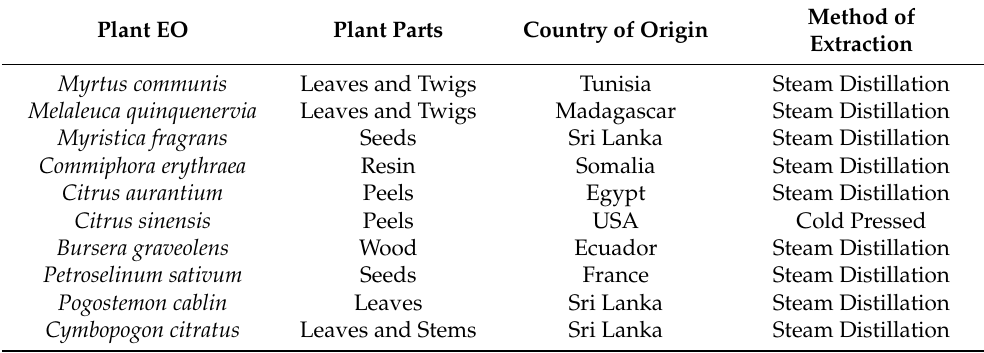
Table 8. The plant parts, their origin, and the method of extraction used to produce the essential oils (EOs) used in the present study. Information was obtained from supplier websites. Method of Plant EO Plant Parts Country of Origin Extraction Myrtus communis Leaves and Twigs Tunisia Steam Distillation Melaleuca quinquenervia Leaves and Twigs Madagascar Steam Distillation Myristica fragrans Seeds Sri Lanka Steam Distillation Resin Somalia Citrus aurantium